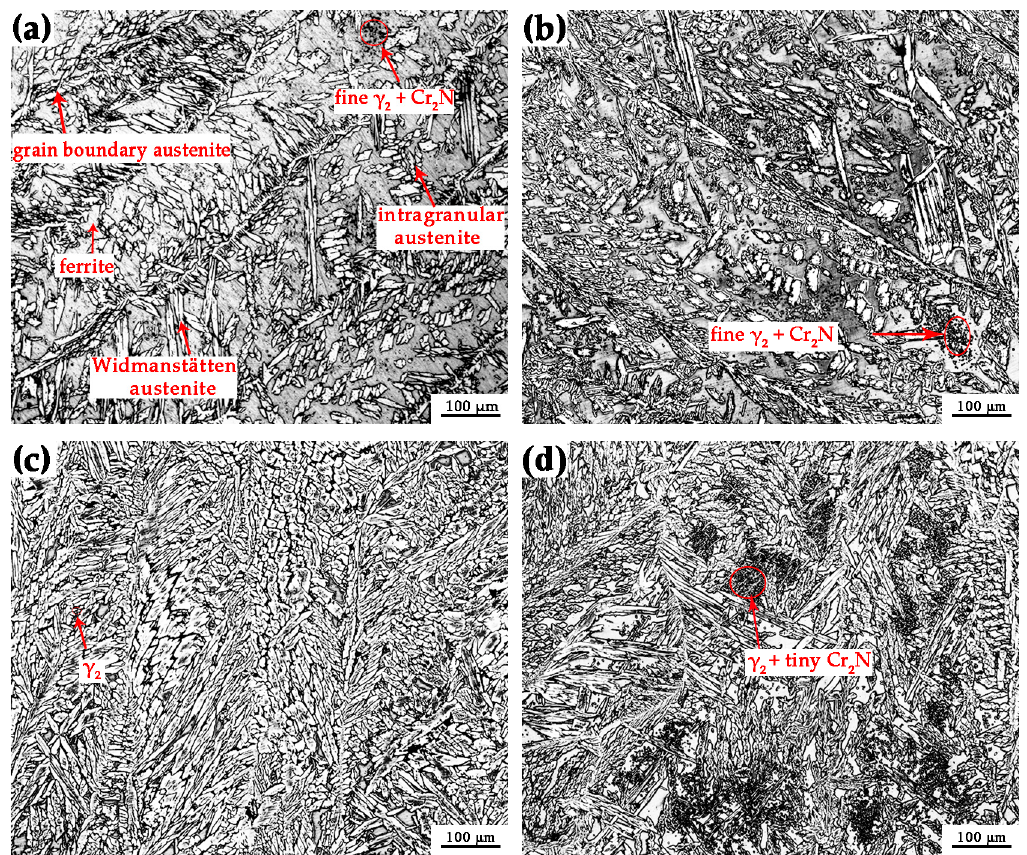
Figure 6. Optical microstructures of the central weld metals: ( a ) Specimen 1; ( b ) Specimen 2; ( c ) Specimen 3; ( d ) Specimen 4. Table 3. Main alloy elements contents of each phase (wt %).